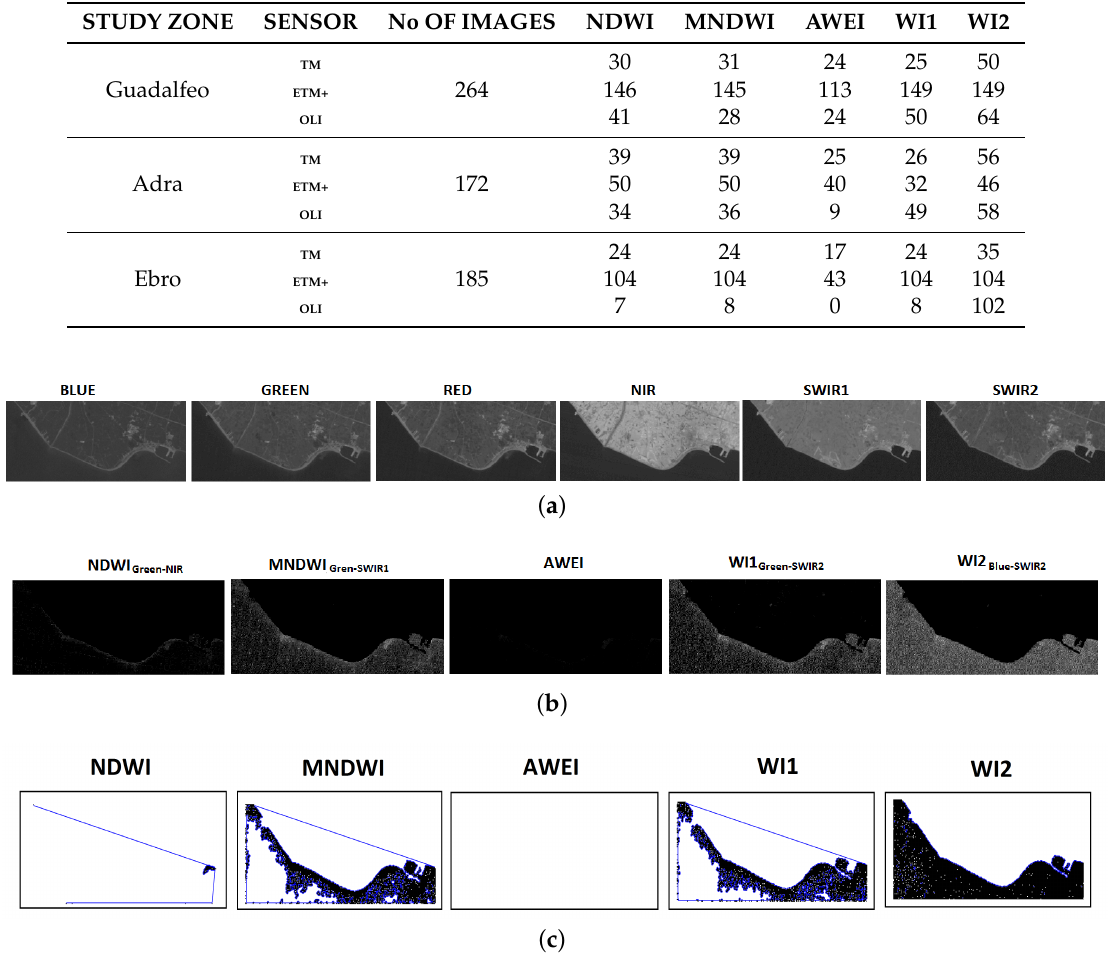
Table 3. Number of images that has no error or noise after applying the methodology for coastline detection with the different indexes